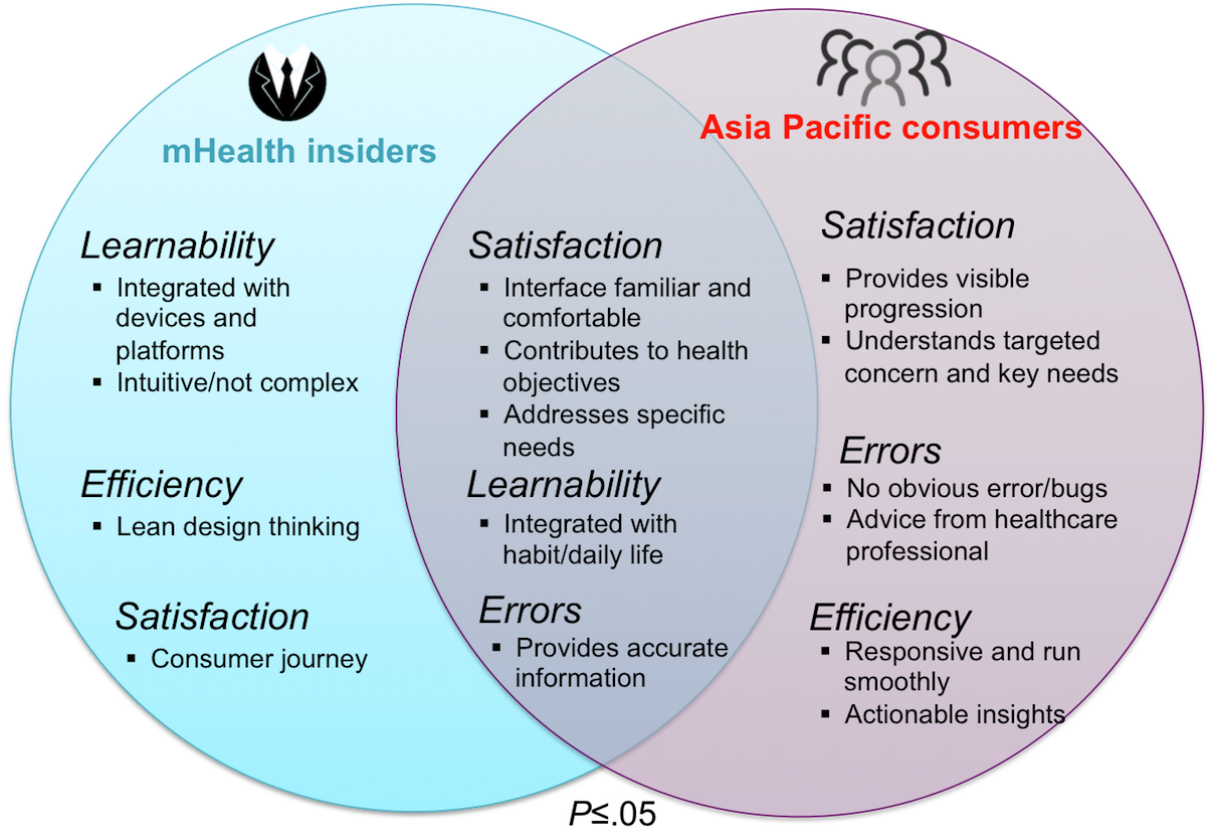
Figure 13. Comparison of top concerns from mHealth insiders versus Asia Pacific